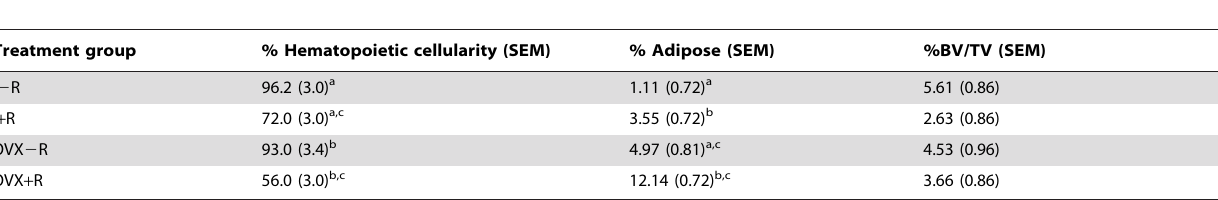
Table 3. Comparison of group least squares means ( 6 SEM) of hematopoietic cellularity, adiposity, and bone volume in intact (I) and ovariectomized (OVX) mice without radiation ( 2 R) and with radiation ( + R) 30 days after radiation treatment.